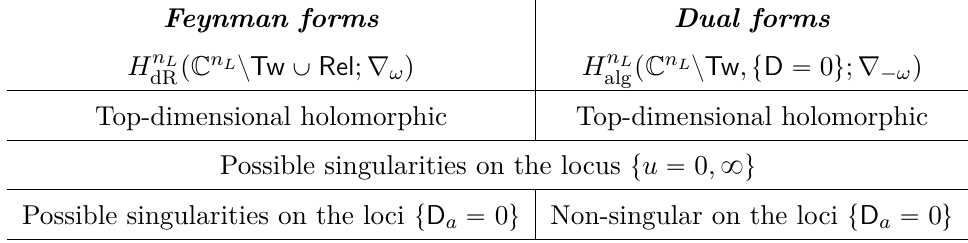
Table 2 . Table comparing the singularity structure of Feynman and dual